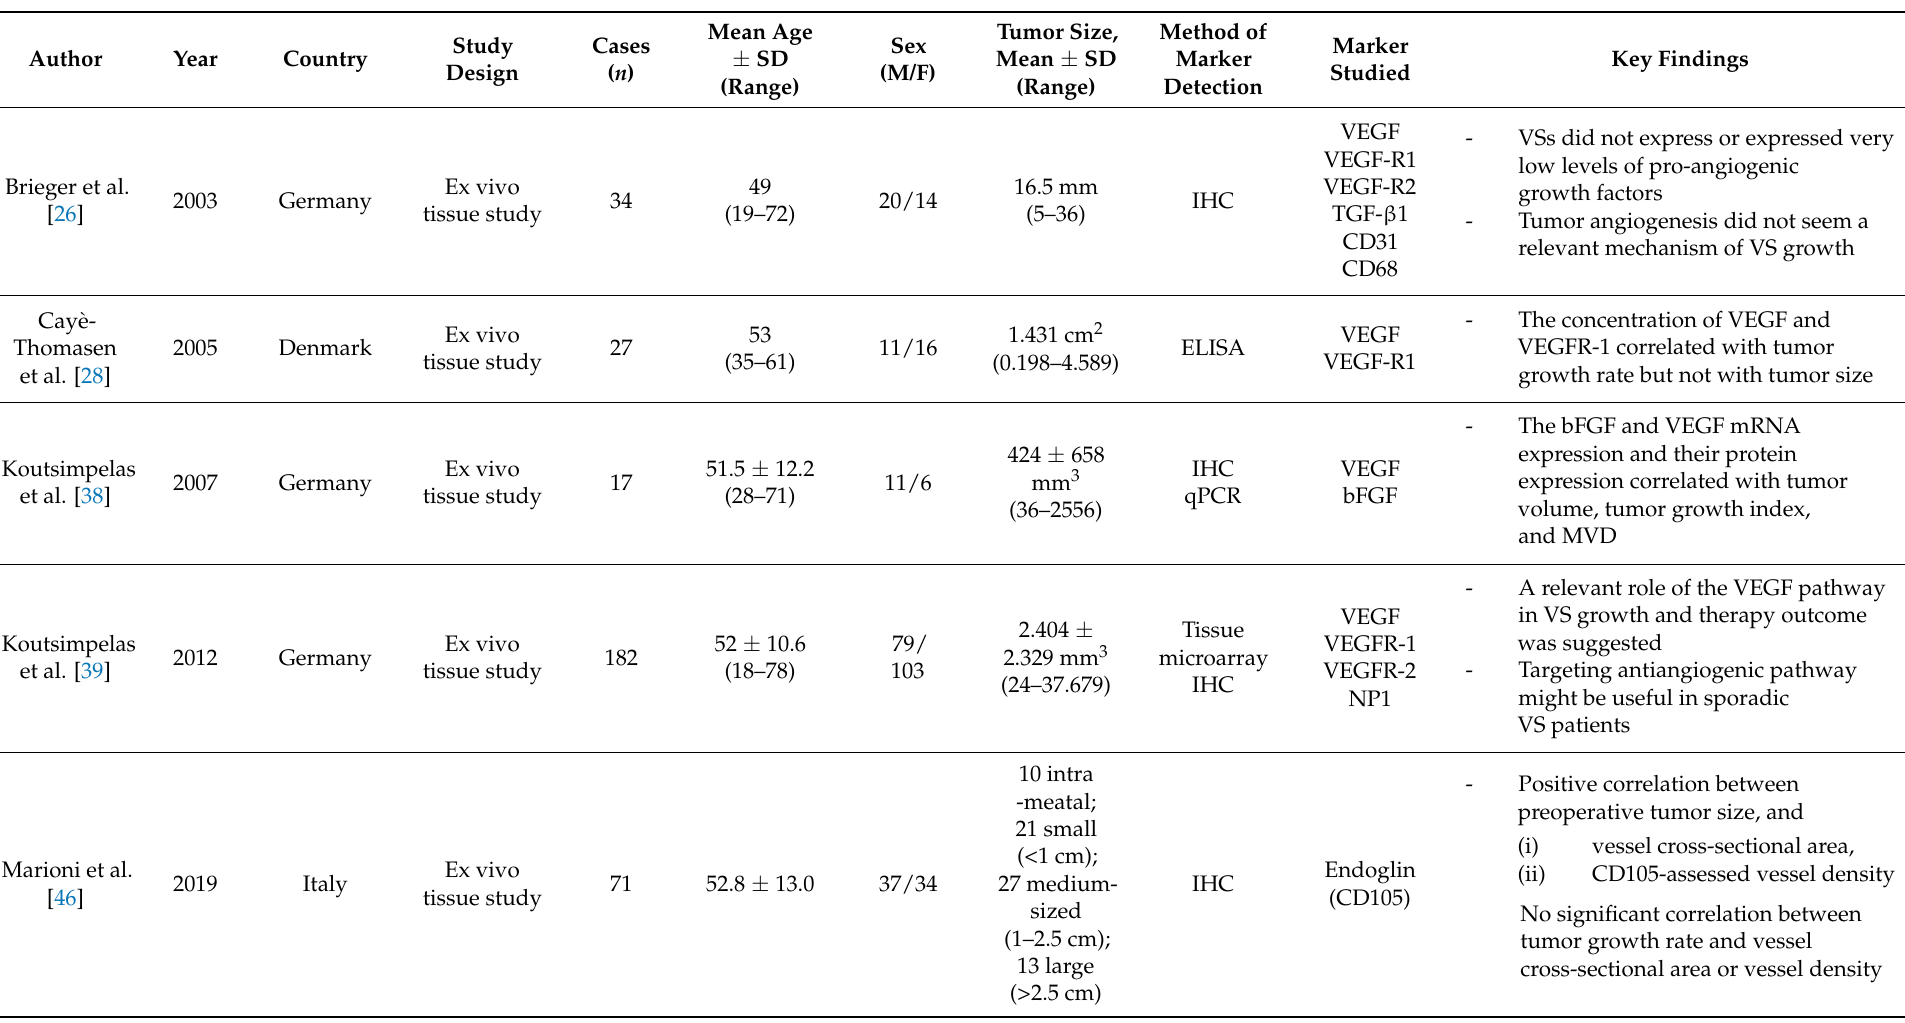
Table 1. Studies examining the role of angiogenetic factors in sporadic vestibular